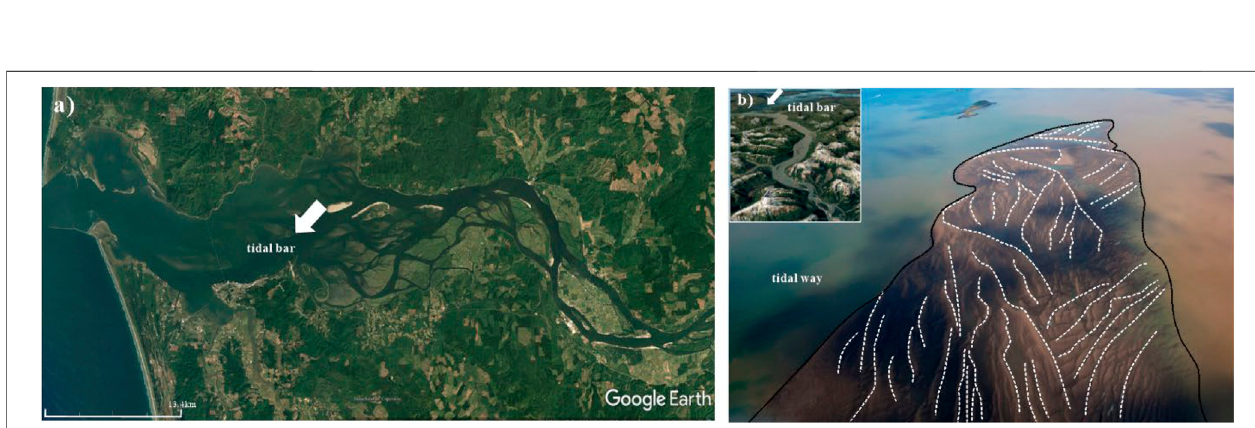
FIGURE 10 | (A) Google Earth satellite image of a modern tide-controlled estuarine sedimentary system (Columbia River Estuary); (B) The low tide level at the Columbia River mouth is a large composited tidal bar.